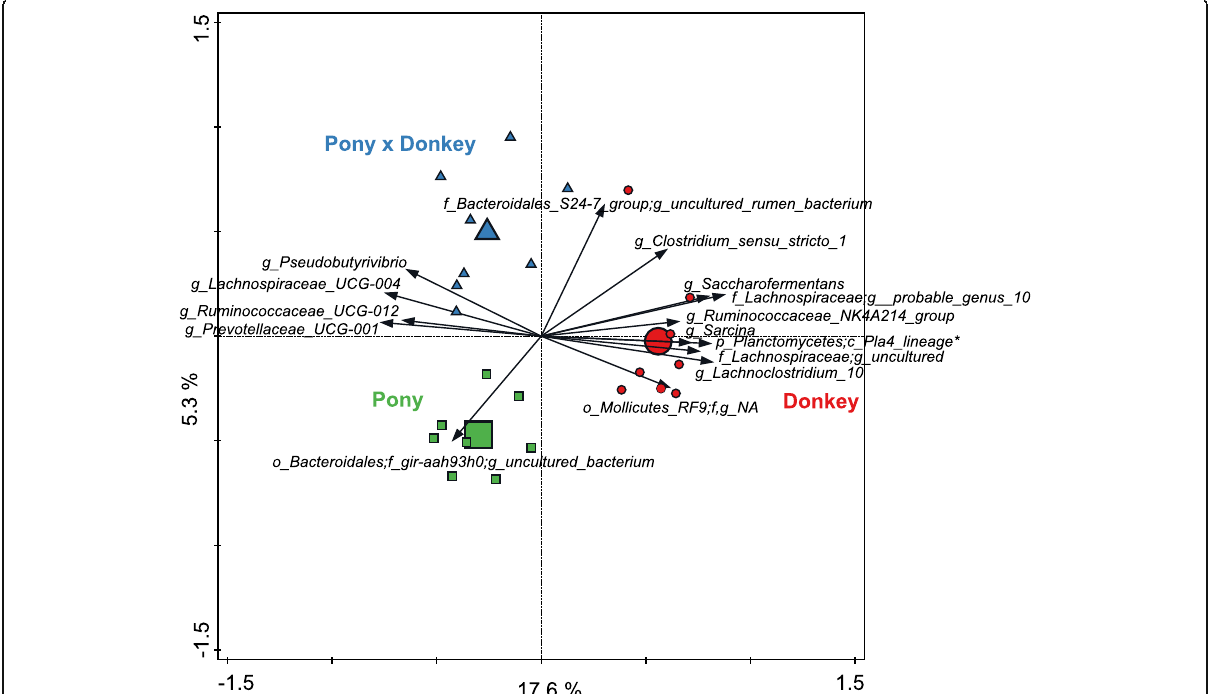
Fig. 2 Redundancy analysis triplot showing the relationship between the top 15 prokaryotic genus-level phylogenetic groupings of the OTUs for which the variation is best explained by the constrained axes. Arrow length indicates the variance that can be explained by equine type, with the perpendicular distance of the equine types to the arrow indicating the relative abundance of the genus-level phylogenetic grouping. Arrow labels indicate the taxonomic affiliation of genus-level phylogenetic groups, with the level (i.e. phylum (p), class (c), order (o), family (f) or genus (g)) and taxon (as defined by the Silva 16S rRNA database) that the groups could be reliably assigned to. For example “ g__ Pseudobutyrivibrio ” represents an OTU reliably assigned to the genus Pseudobutyrivibrio , whereas “ o_ Mollicutes _RF9;f,g__NA ” was reliably assigned to the order Mollicutes _RF9 but the family and genus could not be annotated (NA). *Due to space constraints, one of the arrow labels was shortened on the plot and the full label is as follows: p_ Planctomycetes ;c__Pla4_lineage;o__uncultured_rumen_bacterium;f,g__NA. Equine type means (large symbols) and individual samples (small symbols) are coded by equine type: donkey (red circle), pony (green square) and pony × donkey (blue triangle). Equine type explained 22.8% of the total variation in the dataset, and the plot axes are labelled with the amount of variation they